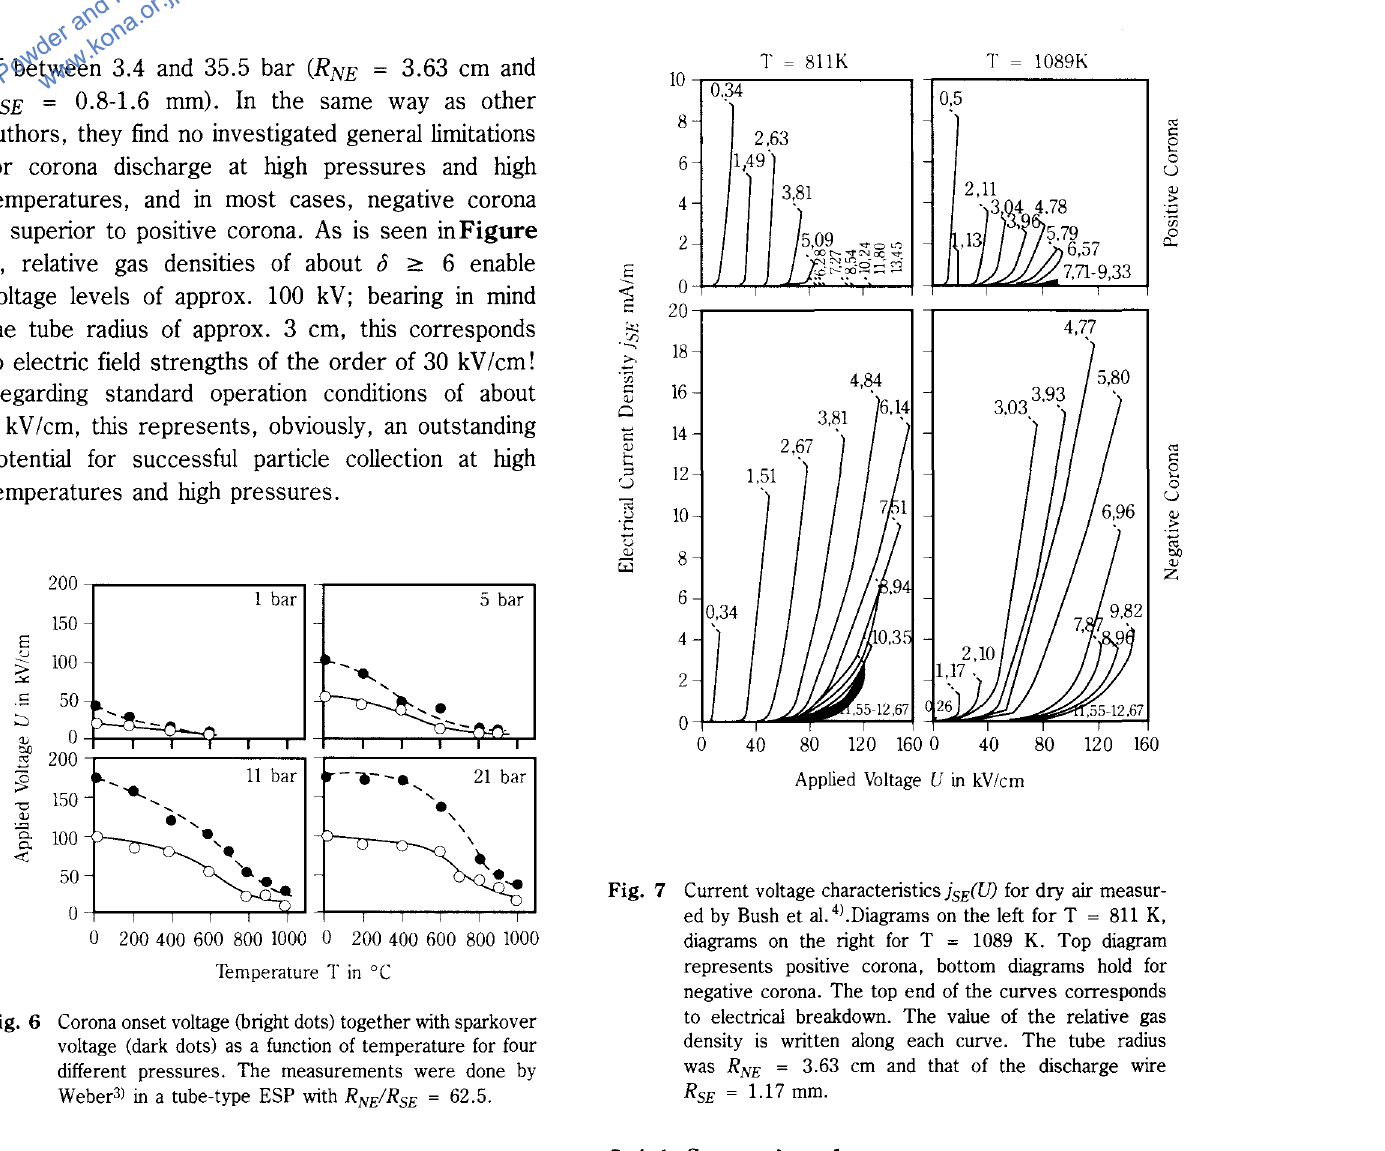
Fig. 6 Corona onset voltage (bright dots) together with sparkover voltage (dark dots) as a function of temperature for four different pressures. The measurements were done by Weber3) in a tube-type ESP with RNEIRsE = 62.5.